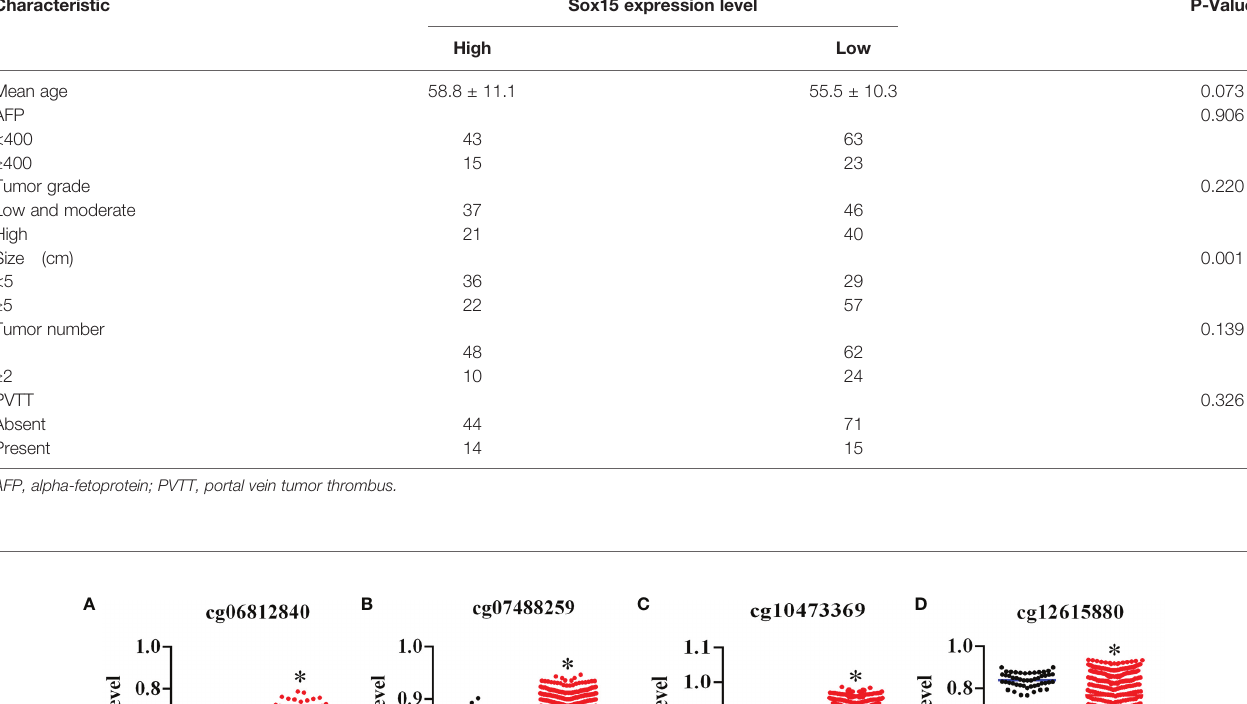
TABLE 1 | Relationship between Sox15 expression and clinicopathological feature in 144 HCC cases. Characteristic